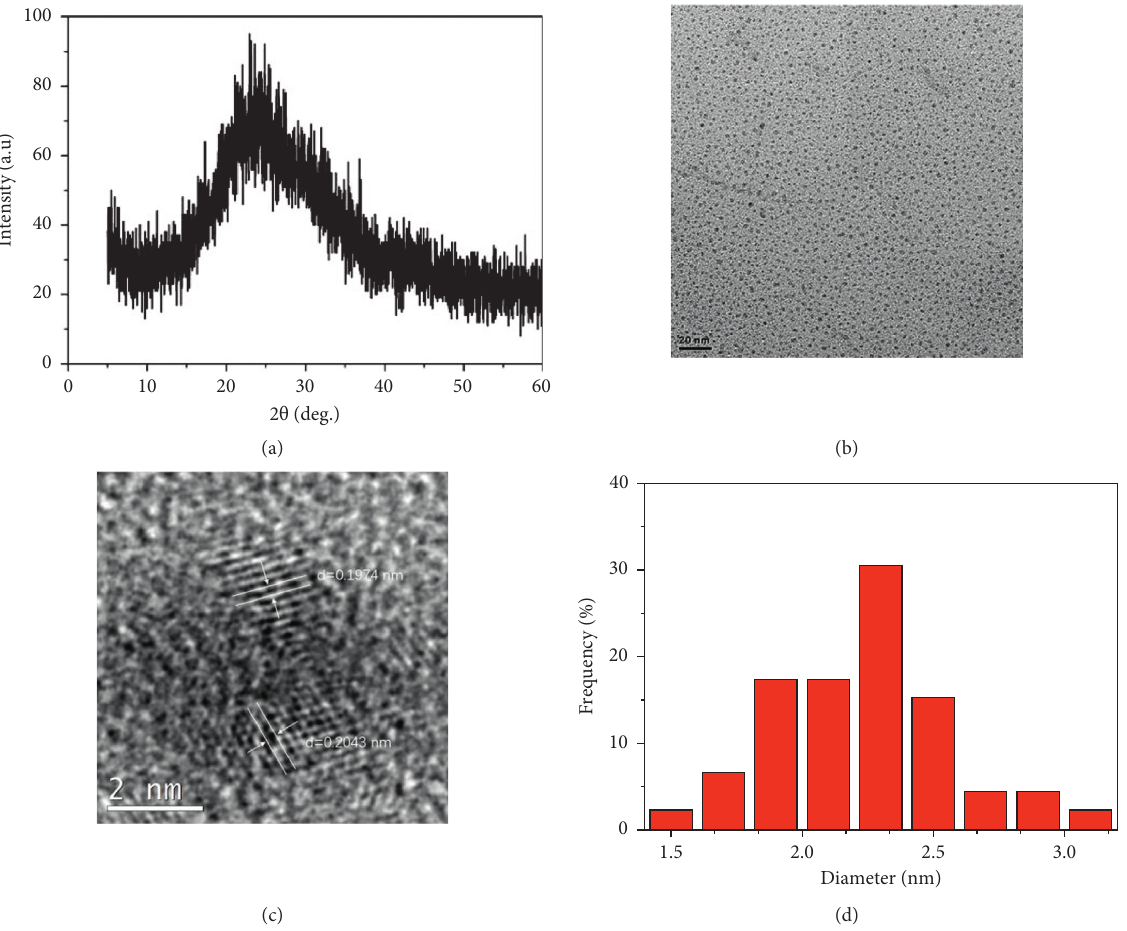
Figure 1: (a) XRD of CDs, TEM image (b), HR-TEM and lattice fringes image (c), and the size distribution (d) of